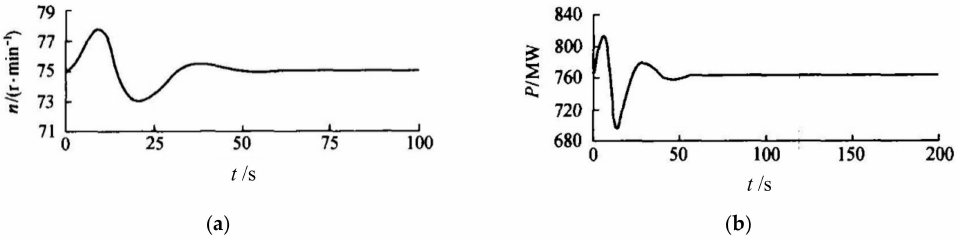
Figure 18. Simulation results of the rotational speed and power output of a hydropower plant with an SCTT [34]. ( a ) Rotational speed, ( b ) power